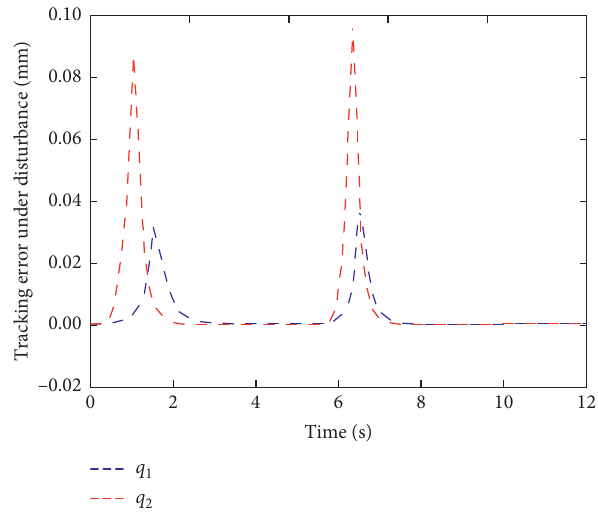
Figure 11: Tracking errors of the two-link robotic manipulator under external